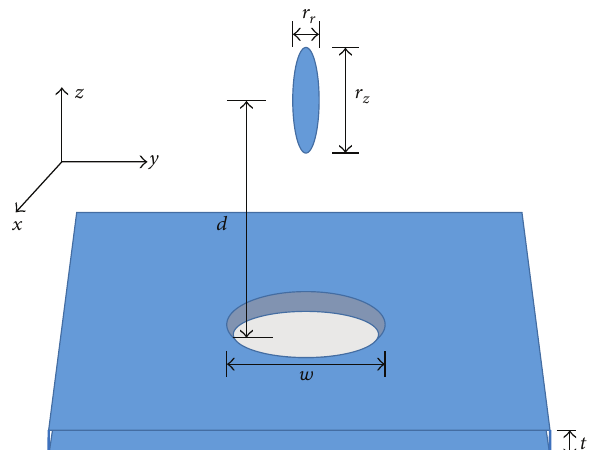
Figure 1: Geometry for achieving Casimir repulsive force: a metal ellipsoid above a thin metal plate with a hole in the center. 𝑑 is the center-center separation, 𝑤 is the plate hole width, 𝑡 is the thickness of the plate, 𝑟 𝑟 is the minor diameter of the ellipsoid, and 𝑟 𝑧 is the major diameter of the